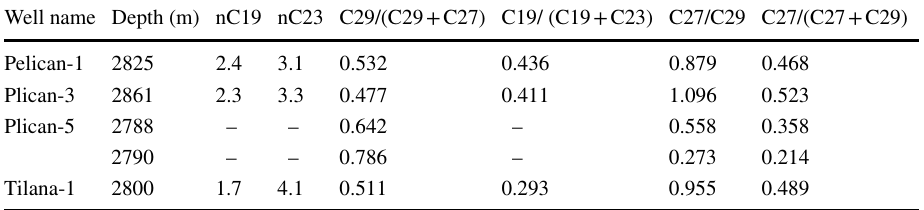
Table 5 Biomarker parameters calculated from steranes, hopanes and terpanes